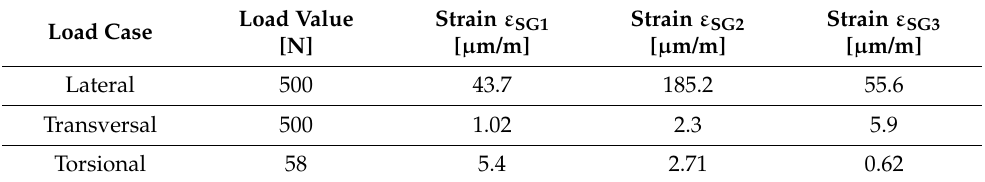
Table 4. Experimental strain values measured in case of investigated load cases for hood “A”.